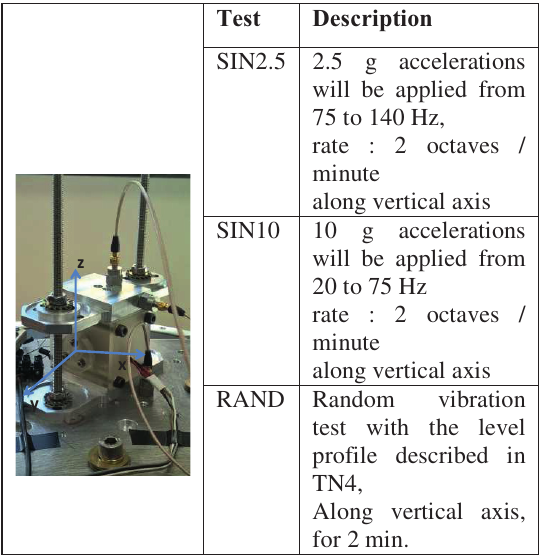
Fig. 1. GENUIN emitter optical layout.